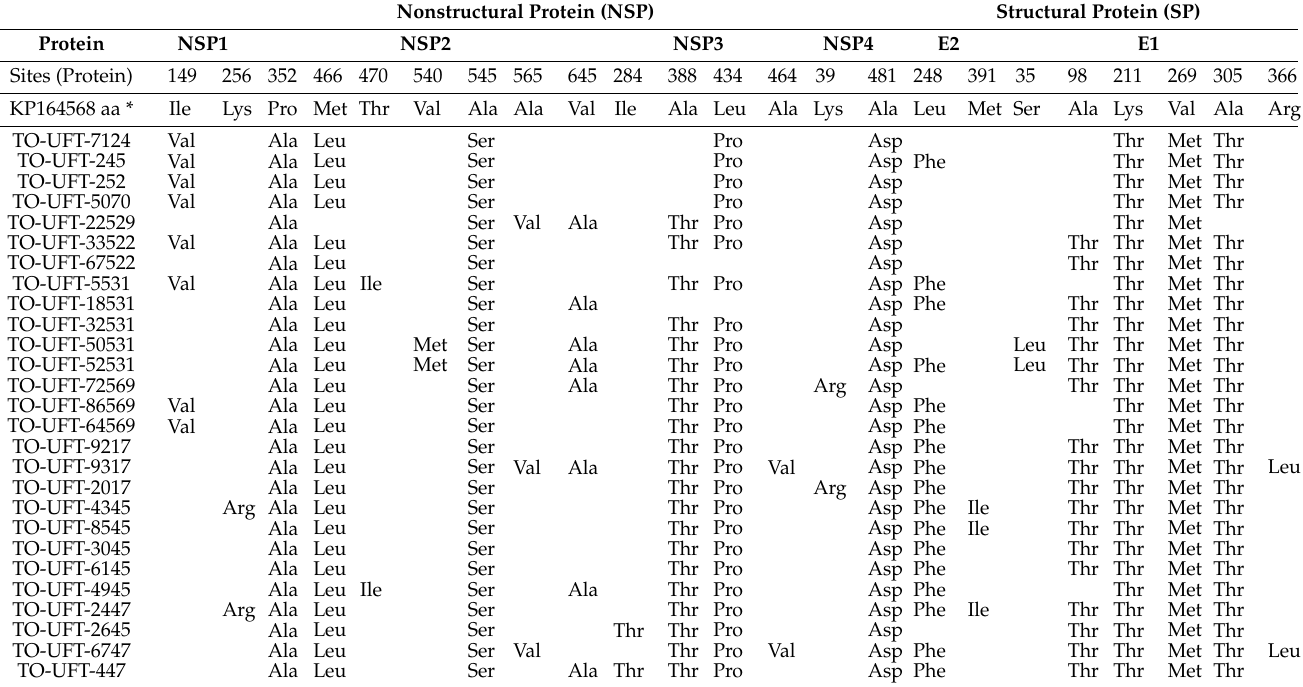
Table 2. Missense mutations found in the newly sequenced genomes of CHIKV from Tocantins, between 2021 and 2022, reported in this study. Showing only mutations observed in at least two sequenced